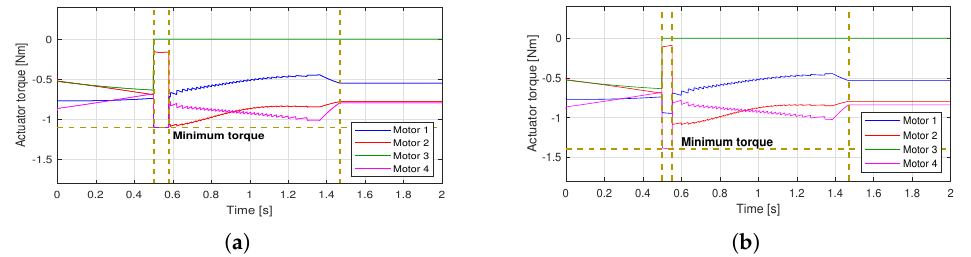
Figure 15. Actuator torques behaviour for different c min limits. Actuator 1 is represented in blue, actuator 2 in red, actuator 3 in green and actuator 4 in violet. ( a ) Actuator torque for c min = − 1.1 Nm; ( b ) Actuator torque for c min = − 1.4